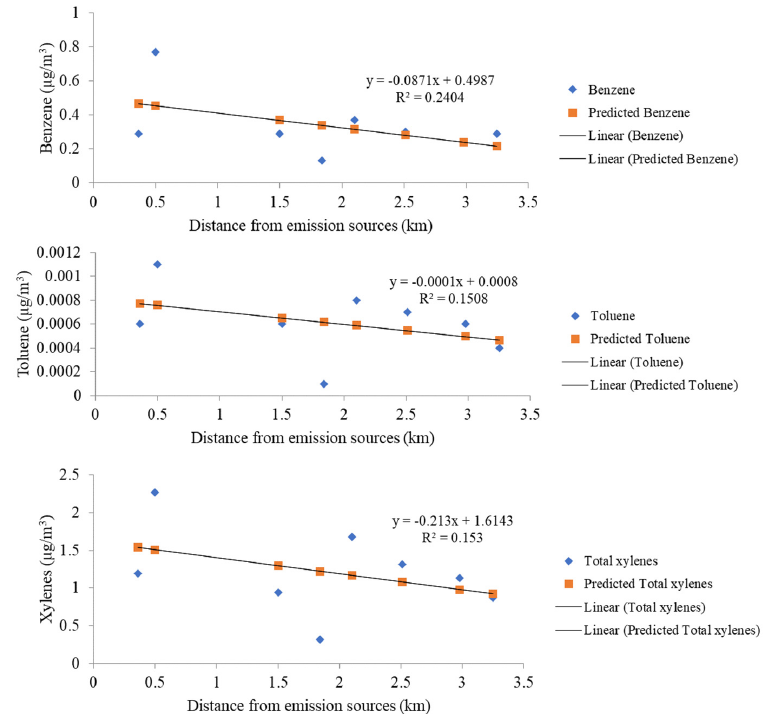
Figure 4. Linear regression analysis between the BTX concentration and the distance from sources.